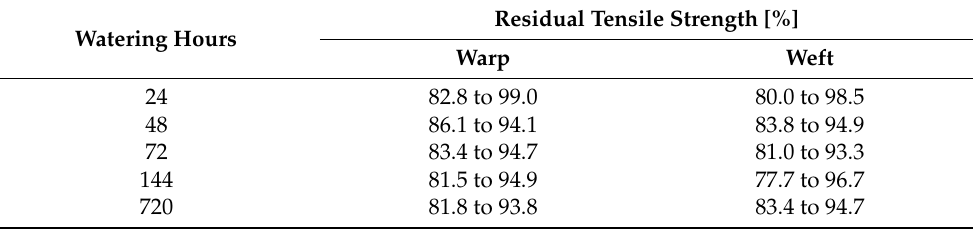
Figure 11. Change of the tensile strength of glass-PTFE samples according to Table 3 at different watering time periods: ( a ) warp direction and ( b ) weft direction. Table 4. Residual tensile strength of glass-PTFE after different watering time periods.